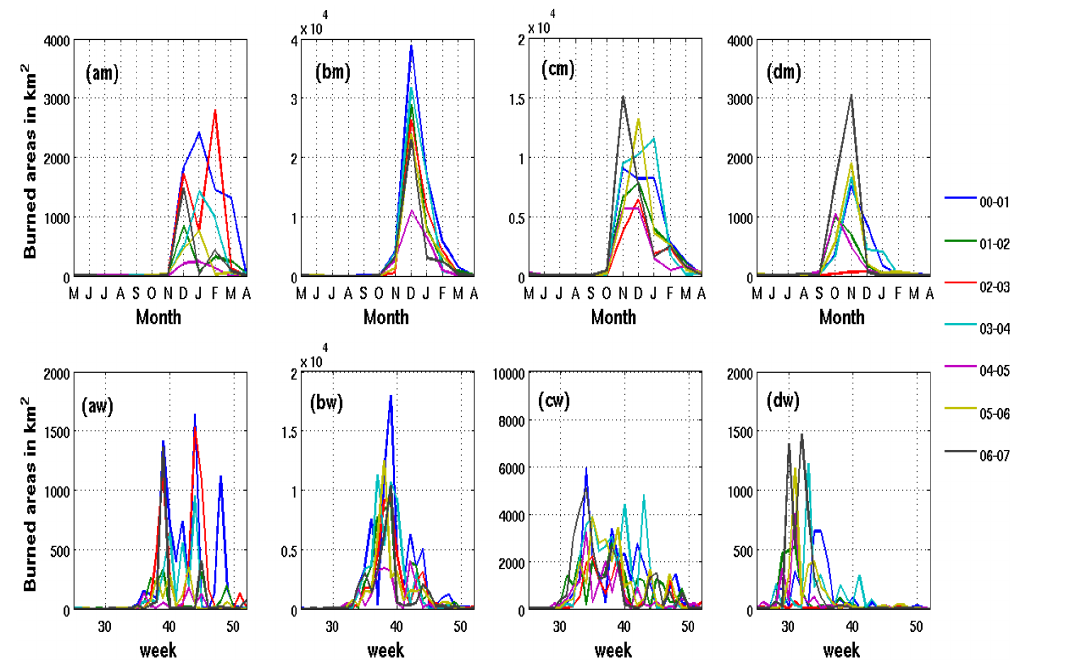
Figure 3. Intra-annual variability in burned areas for the four subregions at monthly (upper row) and weekly timescale (lower row) for subregion 1 (am, aw) , subregion 2 (bm, bw) , subregion 3 (cm, cw) and subregion 4 (dm, dw) . For the weekly variability, there were a few burned areas detected between week 1 and week 7 which are not presented in this graph. Note that axis bounds vary between